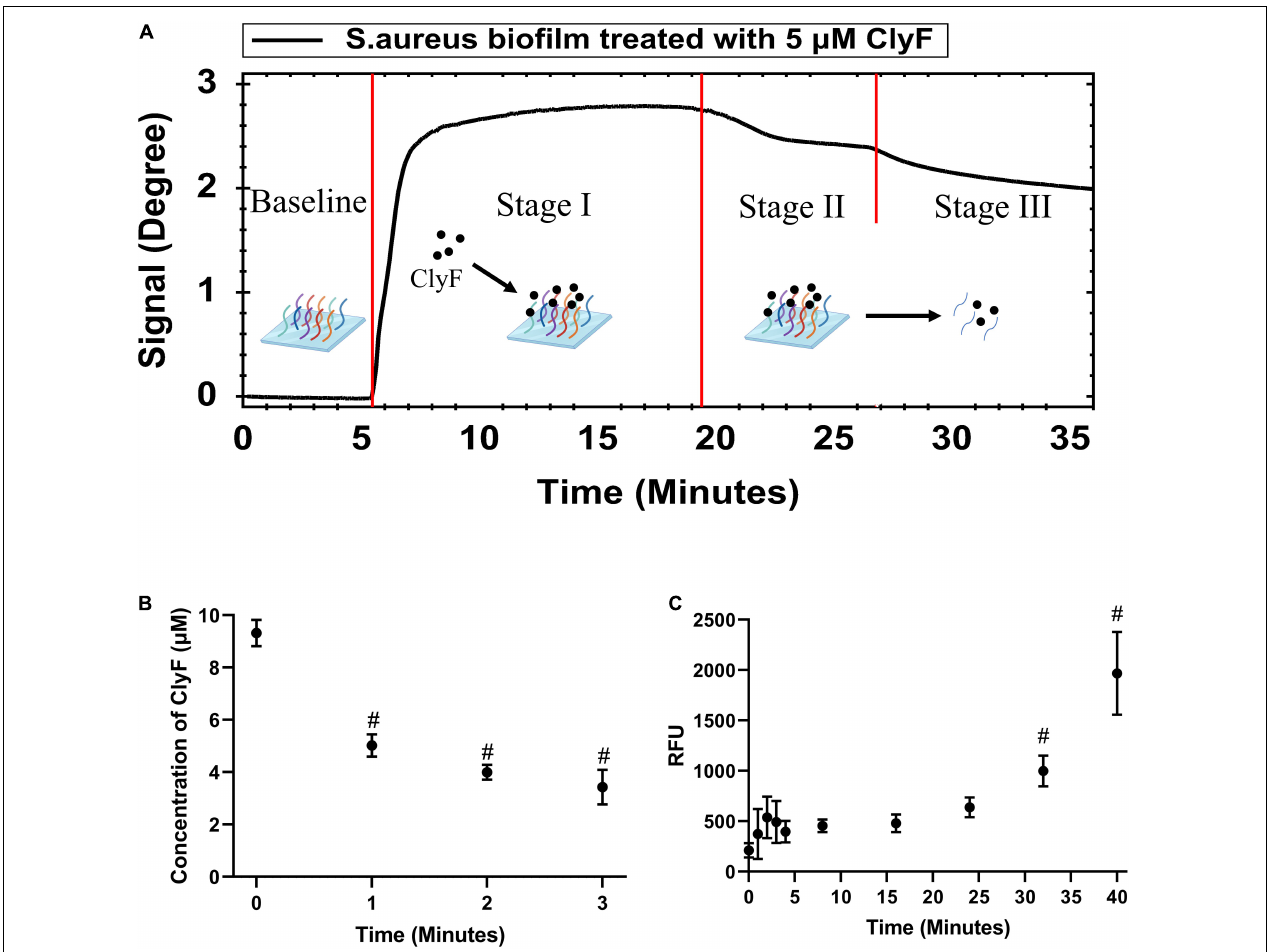
FIGURE 2 | Real-time monitoring and confirmation of cultured-on-chip S. aureus biofilm interactions with lysin ClyF. (A) Representative SPR sensorgram illustrating changes in Peakmin Angle after lysin injection. (B) Monitoring the absorption process by detection of free ClyF concentration. (C) Monitoring the biofilm destruction process based on released ATP by ATP detection. # denotes p <